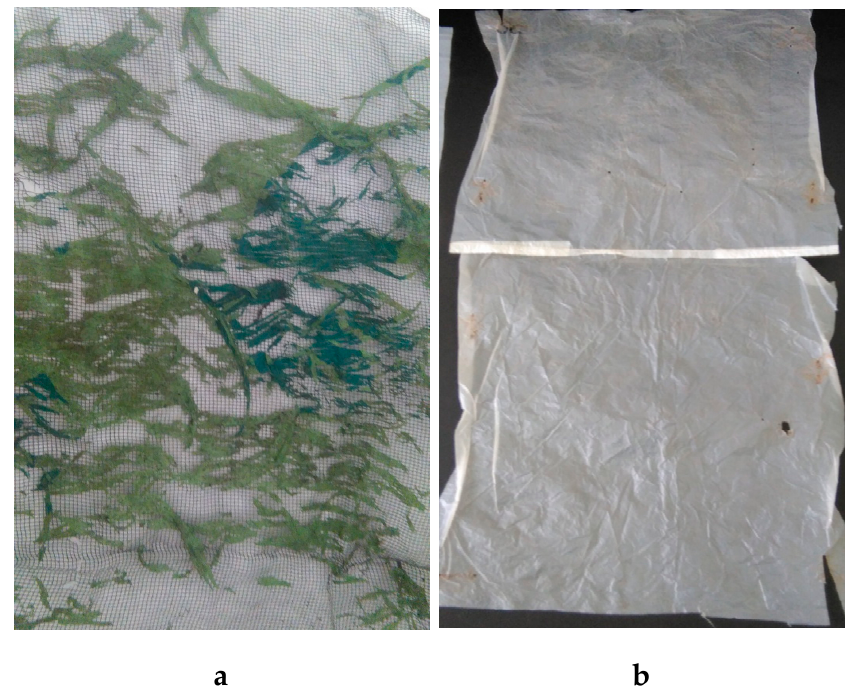
Figure 8. The appearance of the samples after composting: ( a ) biodegradable plastic from corn and potato starch (Sample 3), ( b ) oxo-biodegradable plastic (Sample 9) [photo F. Markowicz]